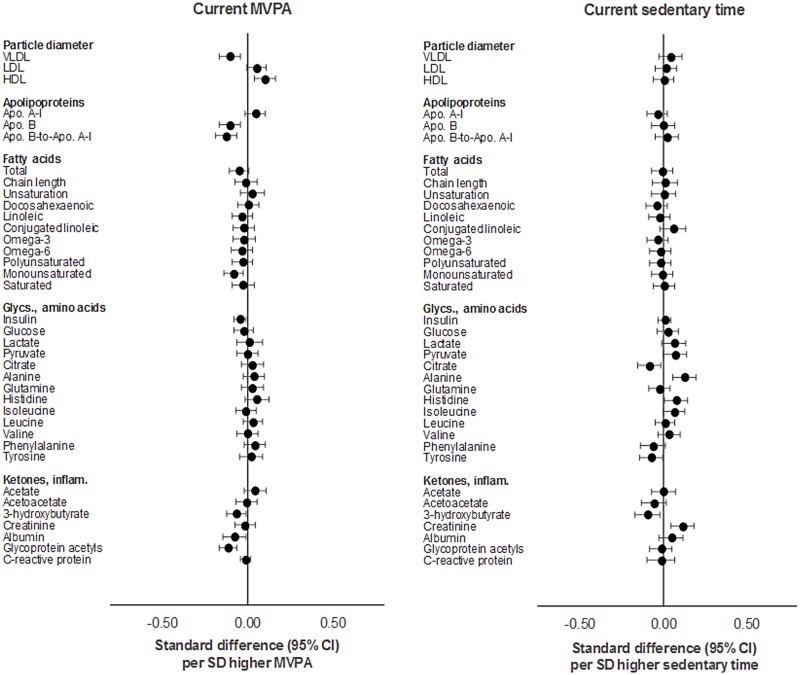
Mutually adjusted associations of current MVPA and sedentary time with lipoprotein particle diameter, apolipoproteins, fatty acids, glycolysis factors, amino acids, ketones, and inflammatory factors at age 15y in ALSPAC.Metabolic traits are in standardised units. Current MVPA/sedentary time defined as measure at age 15y. Models are adjusted for age, sex, ethnicity, maternal education, device wear time and wear month, smoking, alcohol, alternative measure (MVPA or sedentary time), and fat mass index at age 15y. ALSPAC, Avon Longitudinal Study of Parents and Children; MVPA, moderate-to-vigorous physical activity.